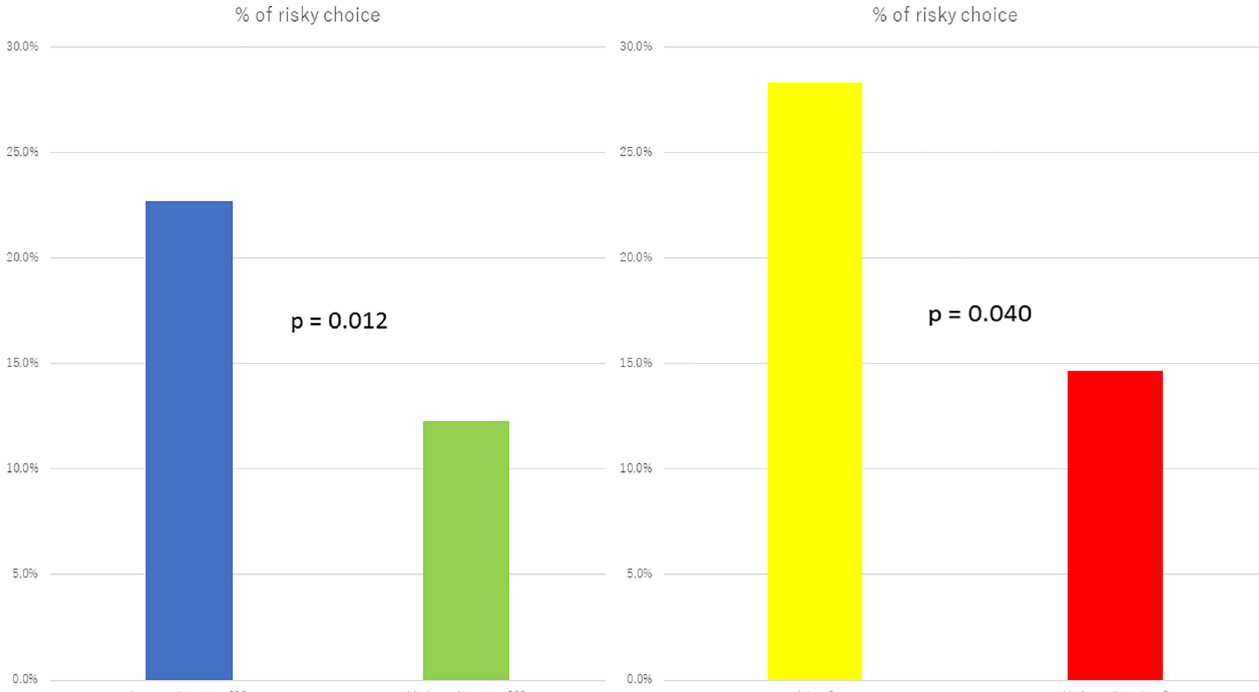
Fig 2. Percentages of risky choice at “Drink problem” in the positive frame without